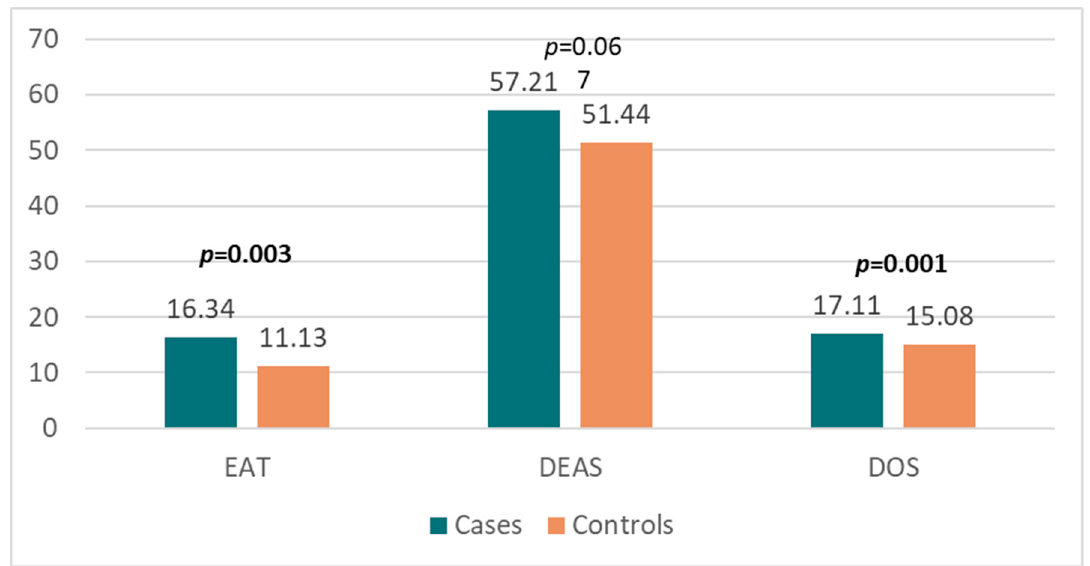
Figure 2. Comparison between cases and matched controls in terms of eating behaviors. EAT = Eating Attitudes Test, DEAS = Disordered Eating Attitude Scale, DOS = Düsseldorf Orthorexia Scale, numbers in bold indicate significant p -values.